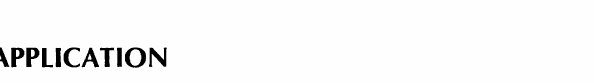
FIGURE 3 Hidden line schematic of the Space Sta tion boundary element model used to determine acoustic